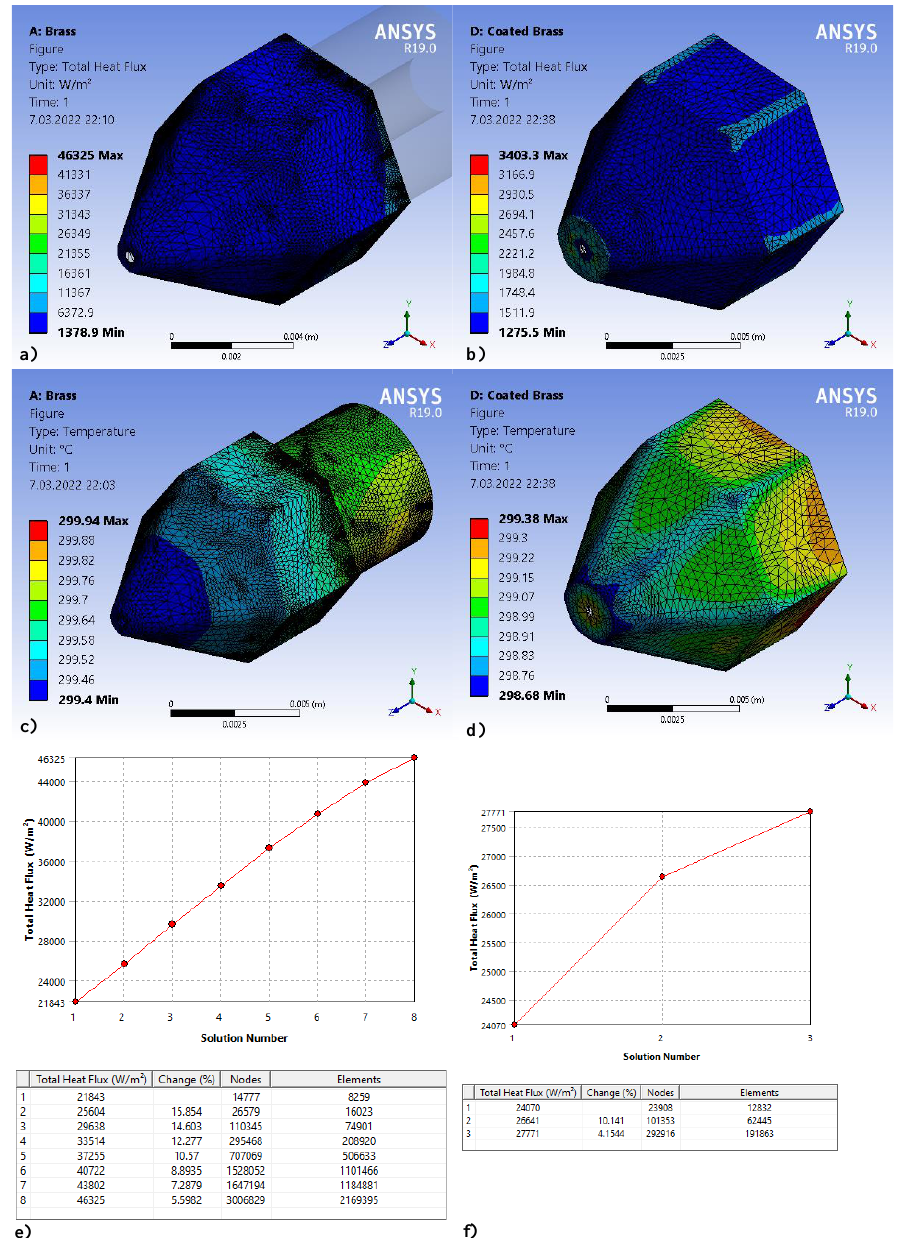
Figure 4. The total heat flux of ( a ) the brass nozzle and ( b ) the coated brass nozzle; temperature distribution of ( c ) the brass nozzle and ( d ) the coated brass nozzle; mesh convergence study based on the total heat flux of ( e ) the brass nozzle and ( f ) the coated brass nozzle.